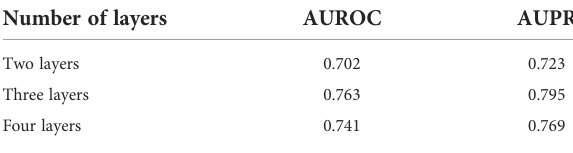
TABLE 1 The effectiveness of deep walk and GCN in